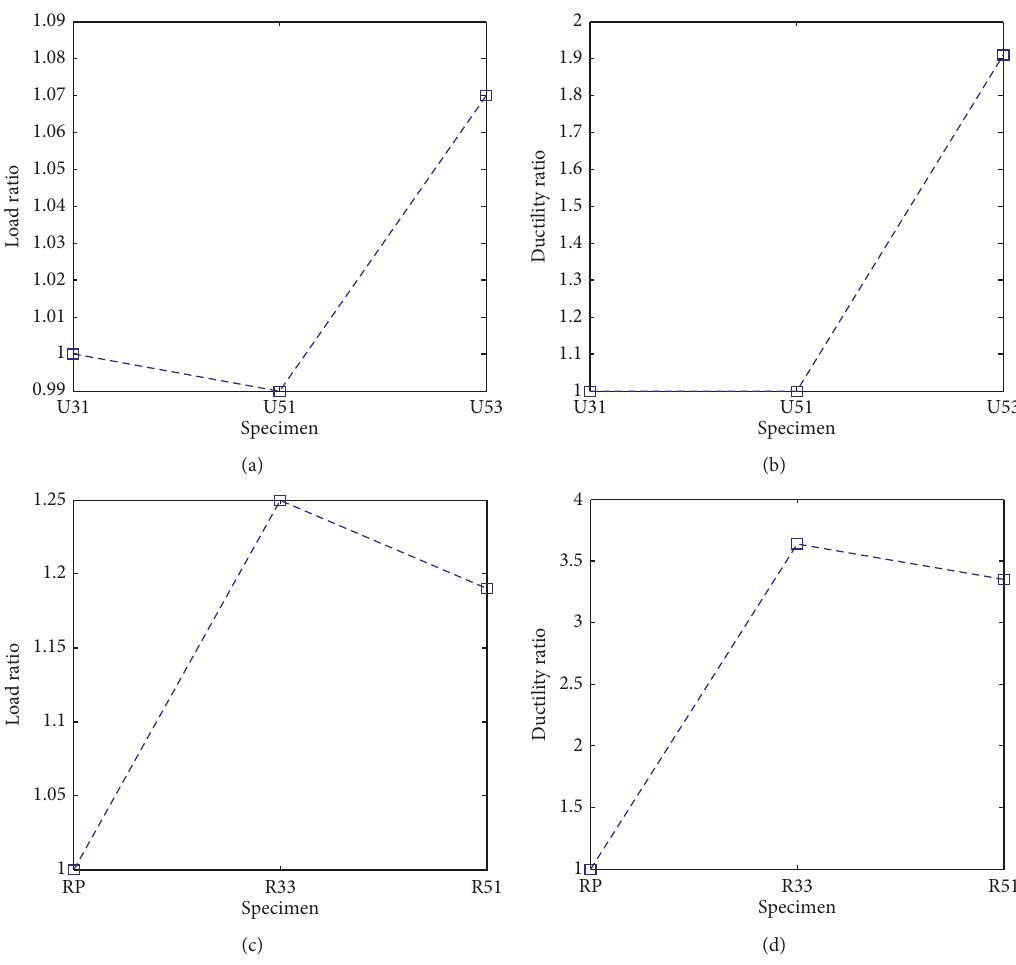
Figure 9: Peak load ratio of (a) U-series and (c) R-series; ductility ratio of (b) U-series and (d)